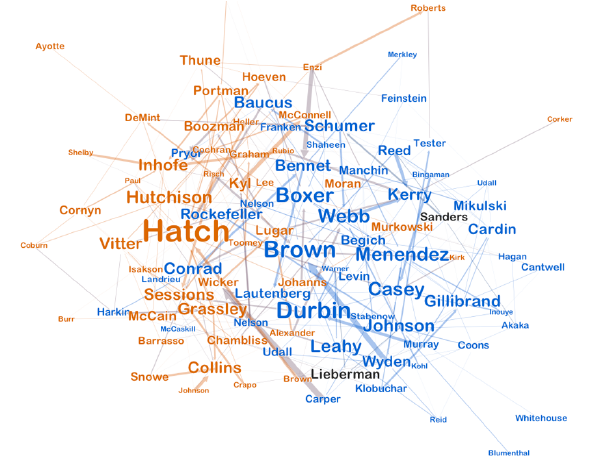
Figure 6. Infection Following Network: the network of who follows whom in public statements using bursting